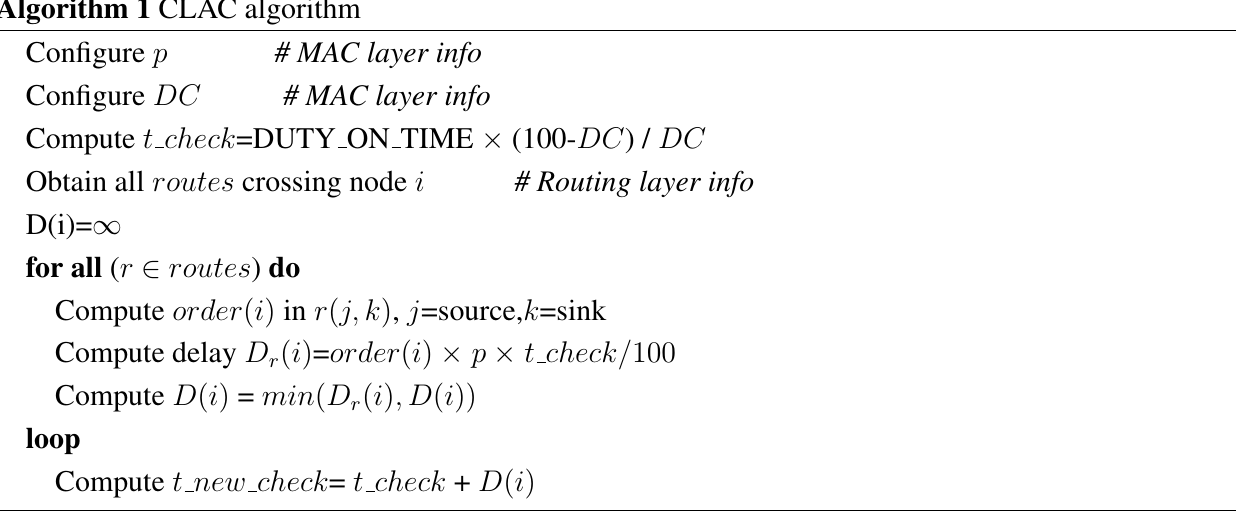
Algorithm 1 CLAC algorithm